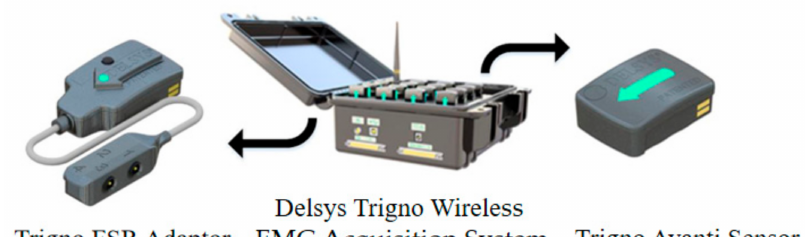
Figure 1. The wireless EMG acquisition